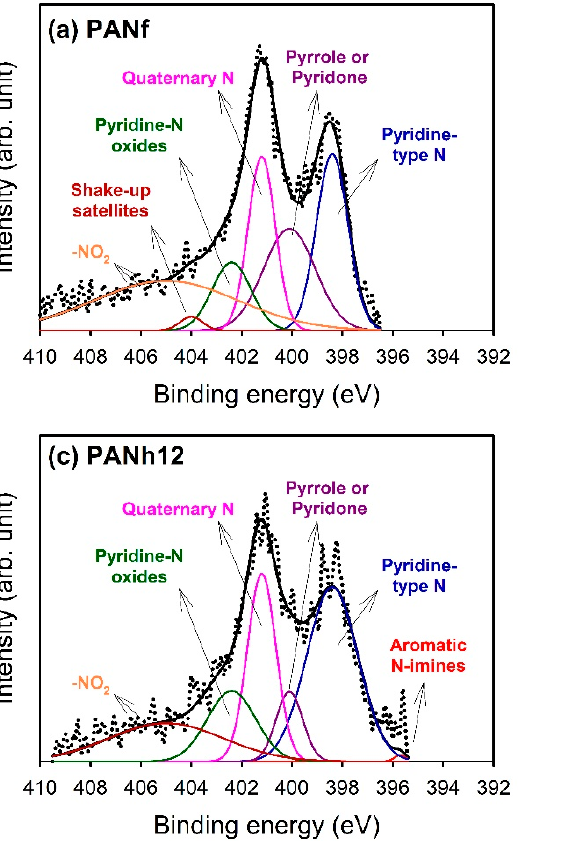
Figure 6. Results of the fits of the high resolution X-ray photoelectron spectroscopy (XPS) N 1s region: ( a ) PANf; ( b ) PANh15; ( c ) PANh12; ( d ) PANp. The values were given in atomic ratio (%) of total intensity. Table 2. Results of the fits of the XPS N 1s region, values shown at. % of total intensity.